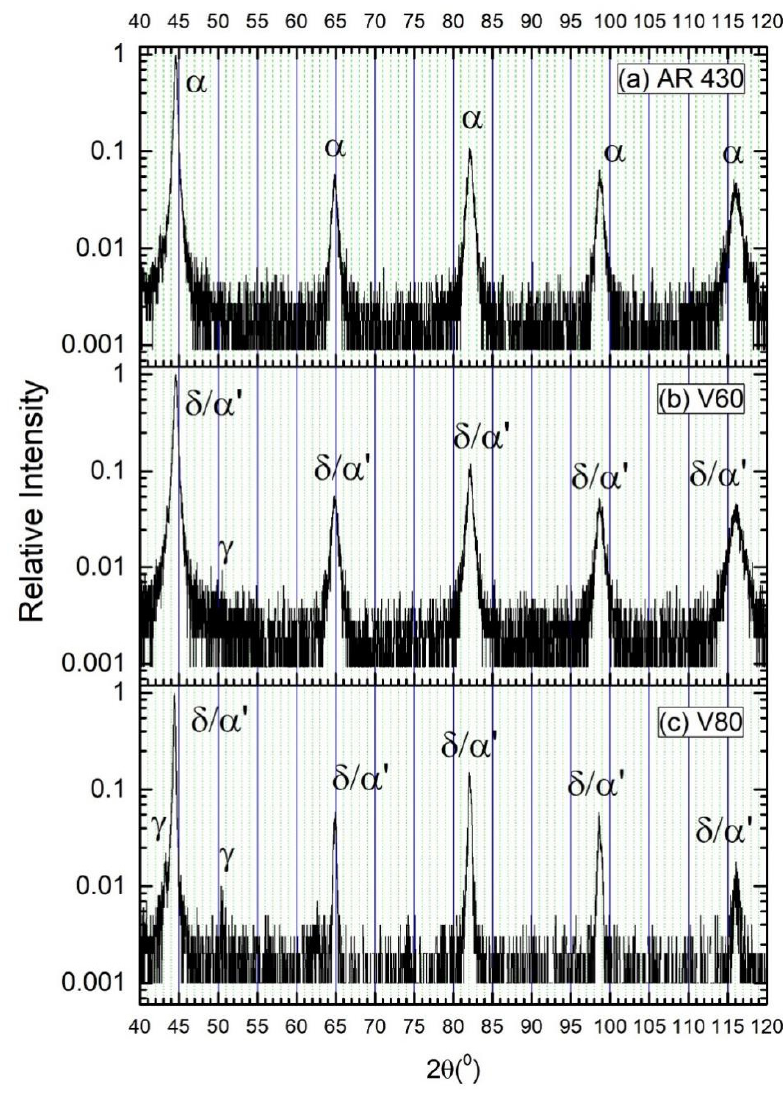
Figure 3. XRD patterns of ( a ) as-received AISI 430 steel, ( b ) V60, and ( c ) V80 before hydrogen charging.